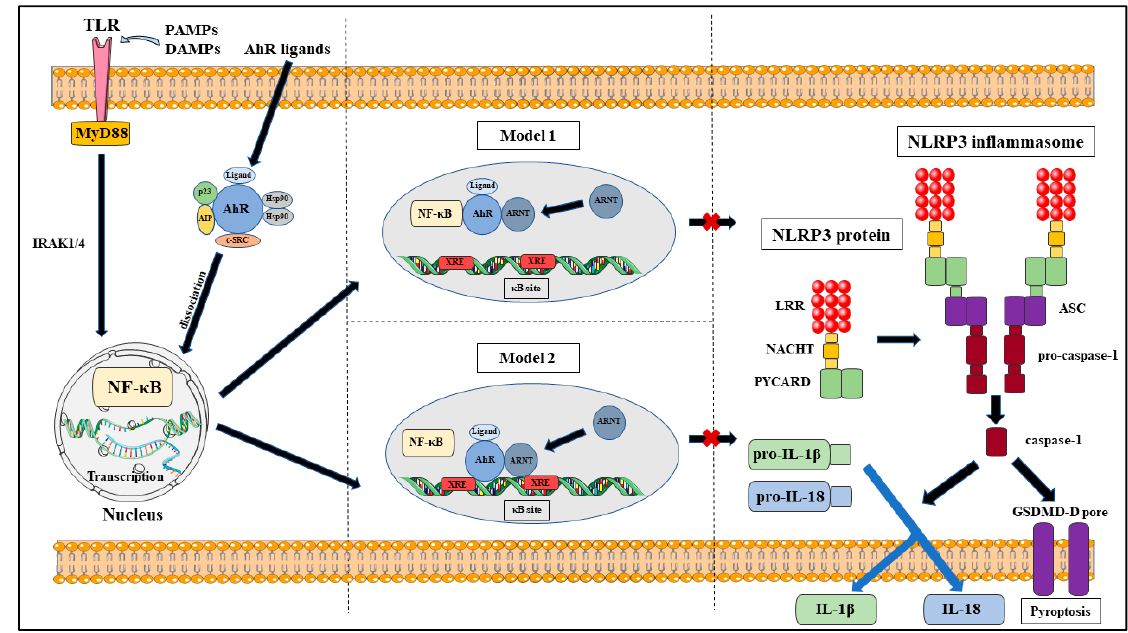
Figure 4. Proposed models of NLRP3 inflammasome inhibition via AhR pathway .